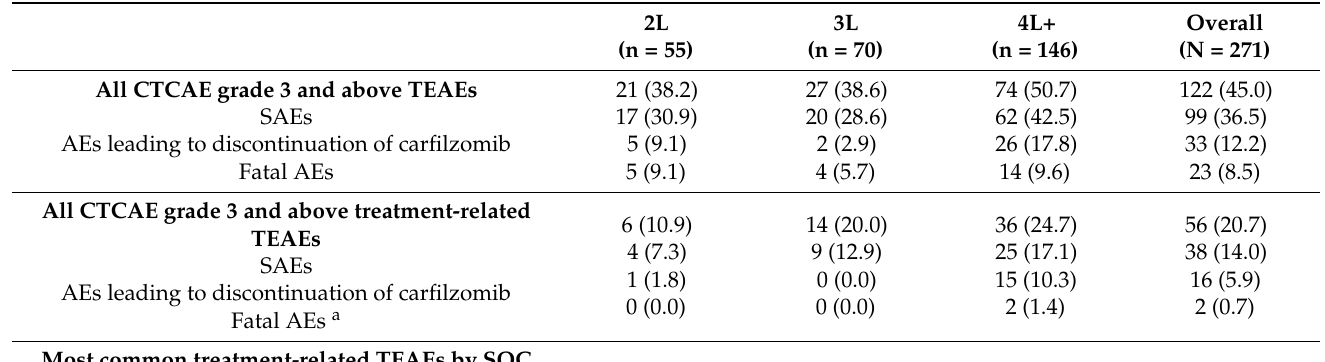
Table 5. Summary of